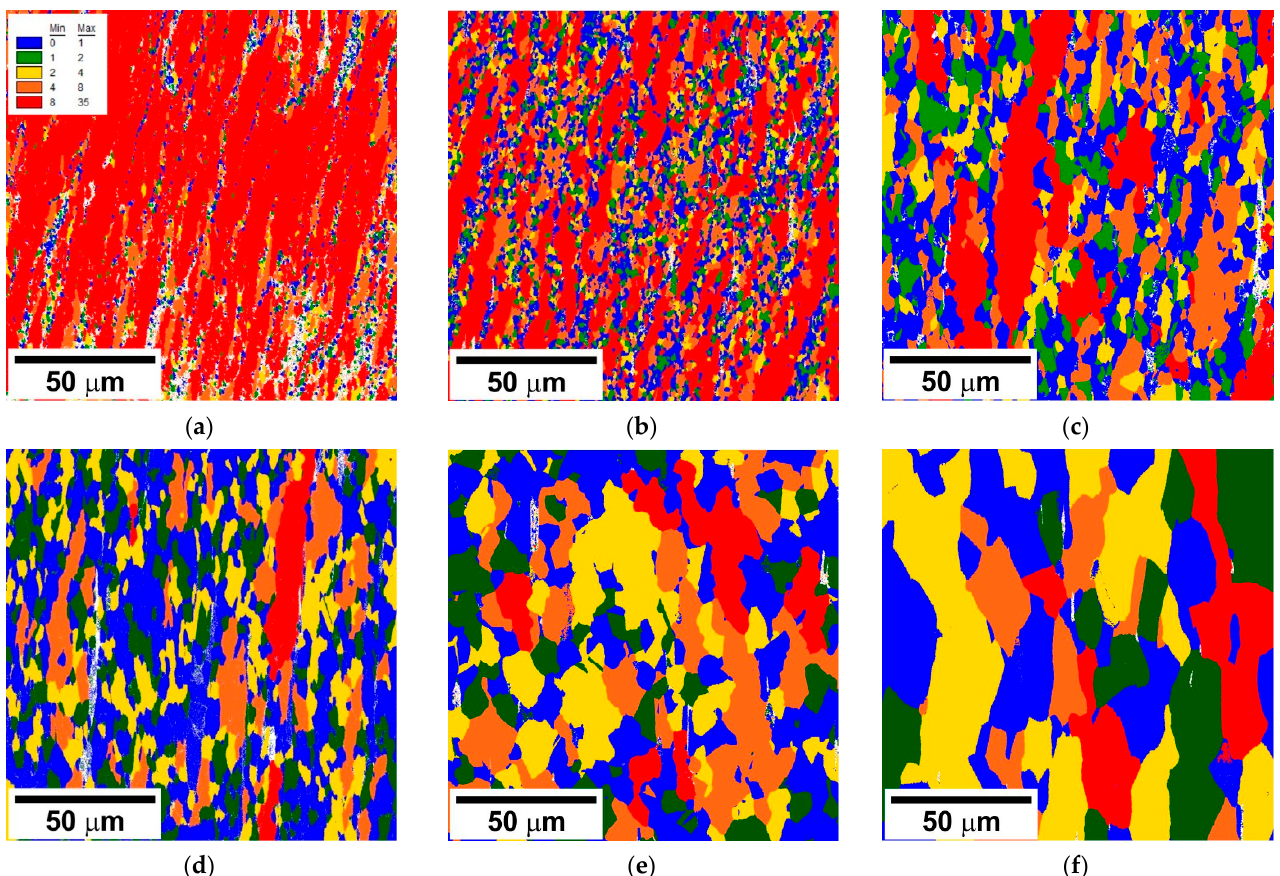
Figure 7. Grain orientation spread in a highly-alloyed austenitic stainless steel subjected to hot compression at 800 °C, 10 − 2 s −